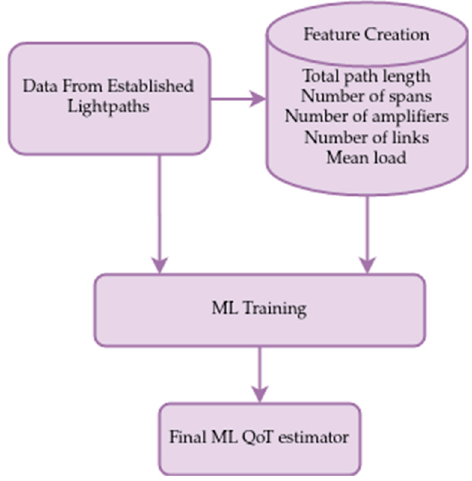
Figure 5. Block diagram of the quality of transmission estimator.